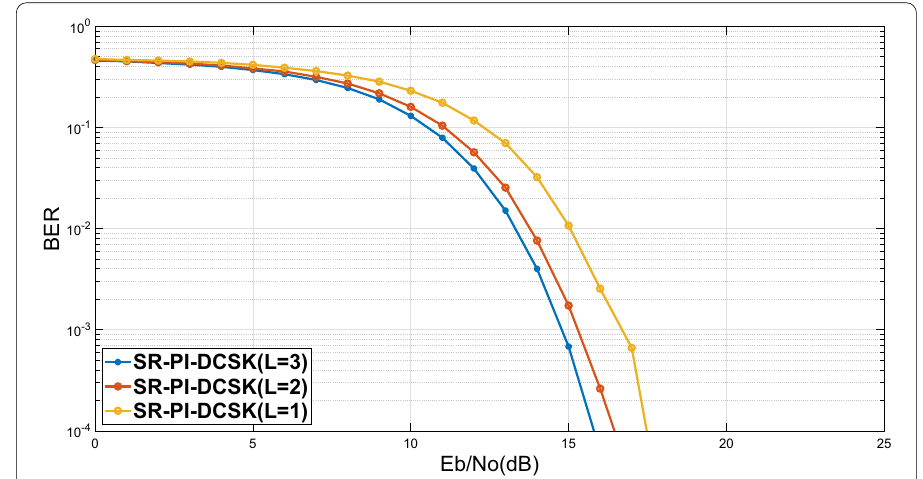
Fig. 10 The bit error rate performance at different frame lengths ( L = 1 , L = 2 and L = 3 ) for SR‑PI‑DCSK for